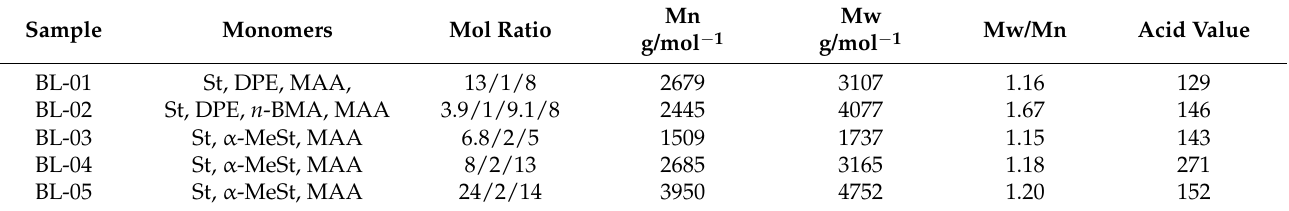
Figure 2. 1 H NMR chart of BL-01. Table 1. Properties of polymers.